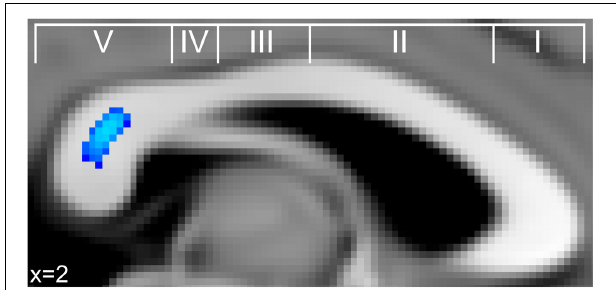
FIGURE 3 | Significant correlations between FA in the corpus callosum and current practice (blue) across musicians in the splenium of the corpus callosum. This finding is in a similar region of the splenium where FA significantly correlated with retrospective hours of musical practice during adolescence in a study by Bengtsson et al.